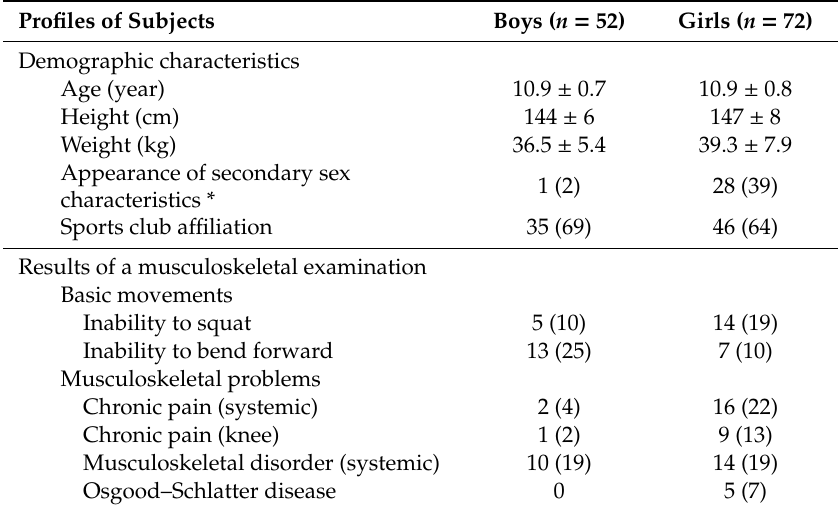
Table 1. Demographic characteristics and results of a musculoskeletal examination of 124 grade 5 and 6 elementary school children involved in a cross-sectional